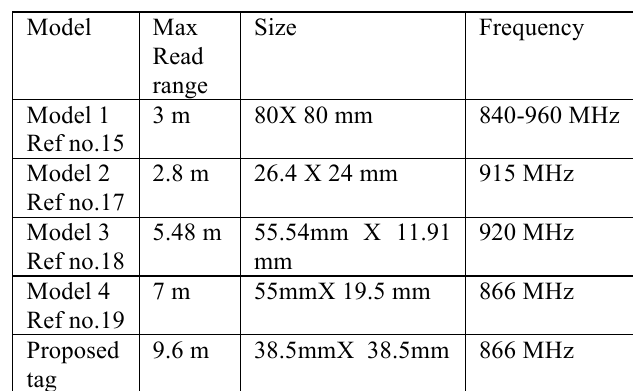
Table 2: comparison of read range and size of the proposed RFID tag with some reported RFID